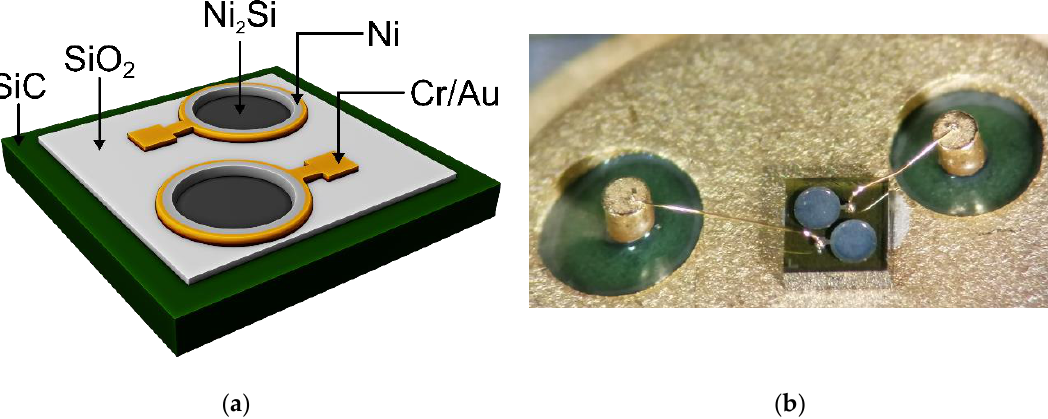
Figure 1. Dual-diode sensing element: ( a ) schematic illustration and ( b ) encapsulated structure.